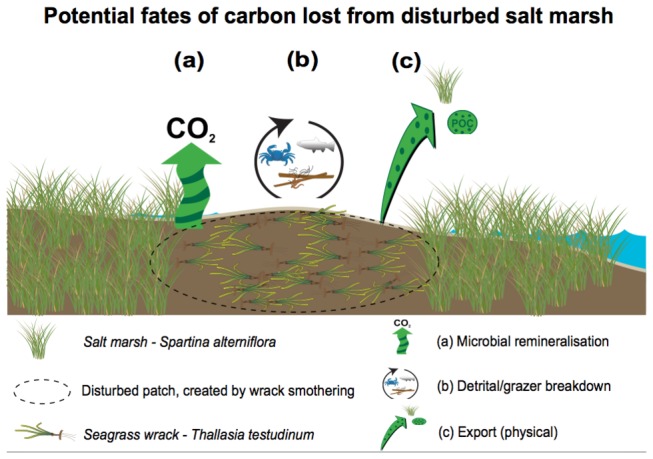
Conceptual diagram illustrating the possible fates of carbon (C) lost from disturbed salt marsh: (a) remineralization of C by microbes and release as CO2; (b) consumption of C by detritivores and grazing animals; (c) physical export (into deeper water, other parts of the marsh, or other habitats), which could lead to re-burial of the C.Diagram produced using the Integration and Application Network (IAN), University of Maryland Center for Environmental Science, Cambridge, Maryland.